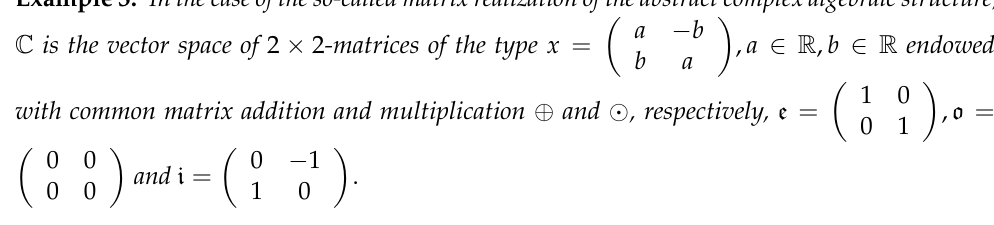
Figure 2. Geometry of quadratic equations with respect to l p -vector multiplication. The exemplary drawn p -circles (with 1 < p < 2) have radii of the sizes drawn for p ∈ ( 0,1 ] and p >